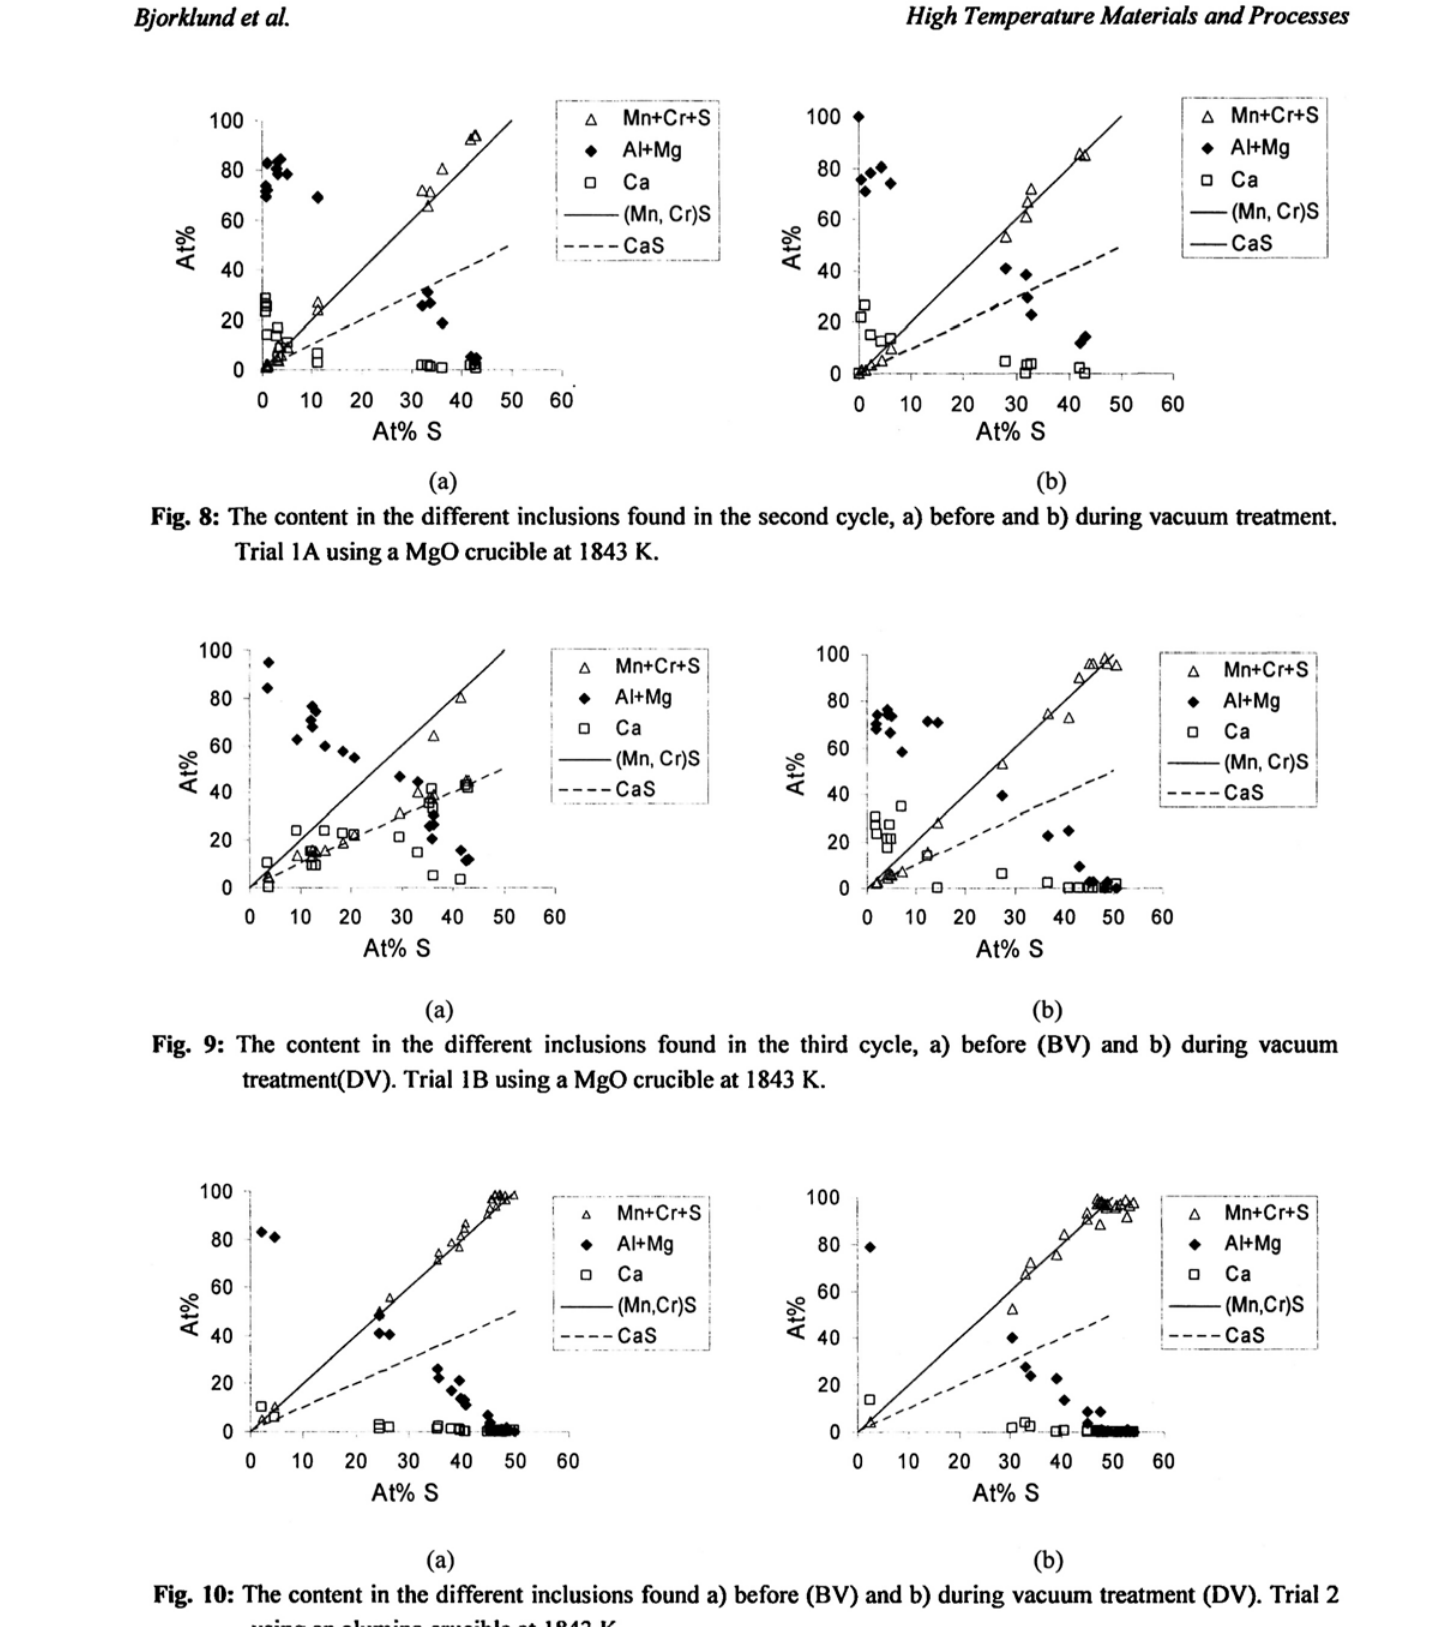
Fig. 10: The content in the different inclusions found a) before (BV) and b) during vacuum treatment (DV). Trial 2 using an alumina crucible at 1843